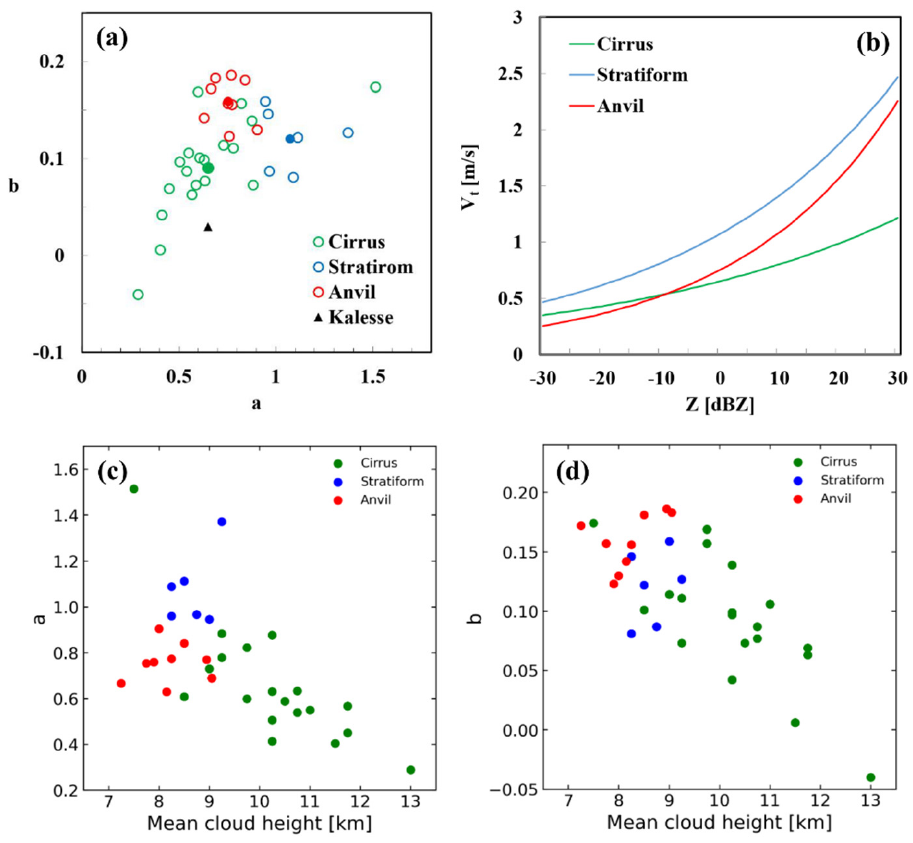
Figure 9. ( a ) Scatterplot of coefficient a and exponent b of V t – Z relationships for ice cloud cases. The colored circles indicate ice cloud types (green: cirrus, blue: stratiform, and red: anvil). The black triangle represents the coefficient and exponent from Kalesse et al. [26]. ( b ) V t – Z relationships for ice cloud types. Scatterplots of mean cloud height and ( c ) coefficient a and ( d ) exponent b of V t – Z relationships for ice cloud cases.